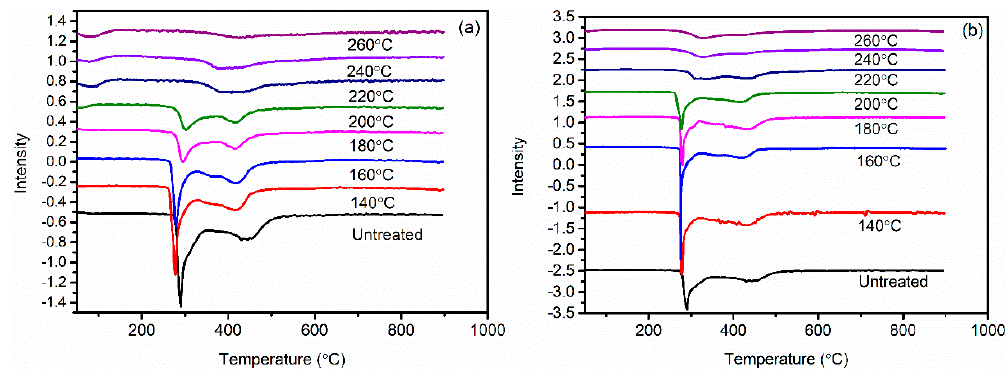
Figure 10. The thermogravimetric (TG) curves of PAN fibers treated at different temperatures: ( a ) in Sc-CO 2 ; ( b ) in air.